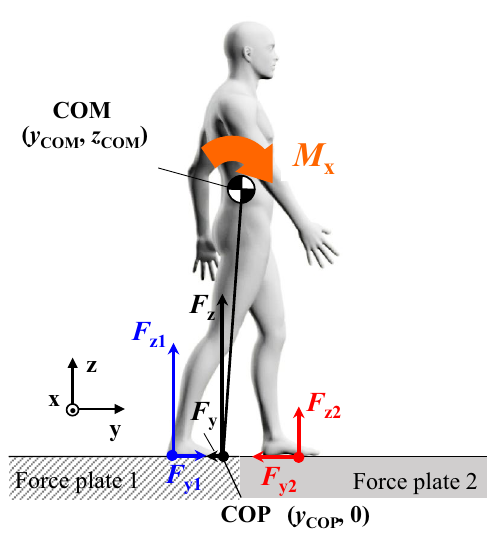
Figure 3. Schematic of the measured and calculated kinetic and kinematic variables in the sagittal plane. F y 1 and F y 2 are the anteroposterior GRF of the first and second force plates, respectively. F z 1 and F z 2 are the vertical GRF of the first and second force plates, respectively. y COP is the global COP in the anteroposterior direction. y COM and z COM are the position of whole-body COM in the anteroposterior and vertical directions, respectively. M x is the external moment about COM in the sagittal